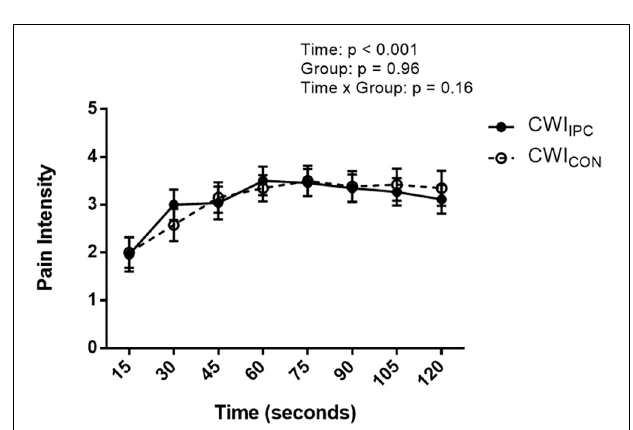
FIGURE 3 | Ratings of pain intensity as reported on a 1–5-point Likert scale every 15 s during a cold-water immersion test in control (CWI CON ) and experimental IPC (CWI IPC ) conditions. Data is represented as mean ±